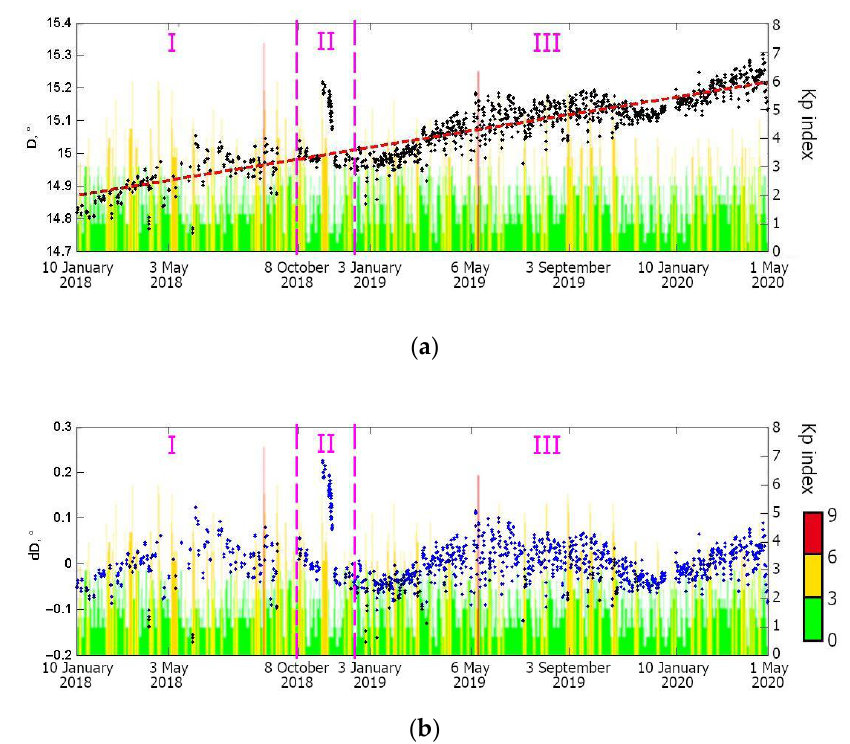
Figure 7. Absolute D measurements for the period of 10 January 2018 – 1 May 2020 for different geomagnetic conditions in the absolute pavilion of the Klimovskaya observatory: ( a ) Initial D plot; ( b ) Detrended dD plot. Right axis on both plots refers to planetary Kp index graph superimposed on D and dD plots.